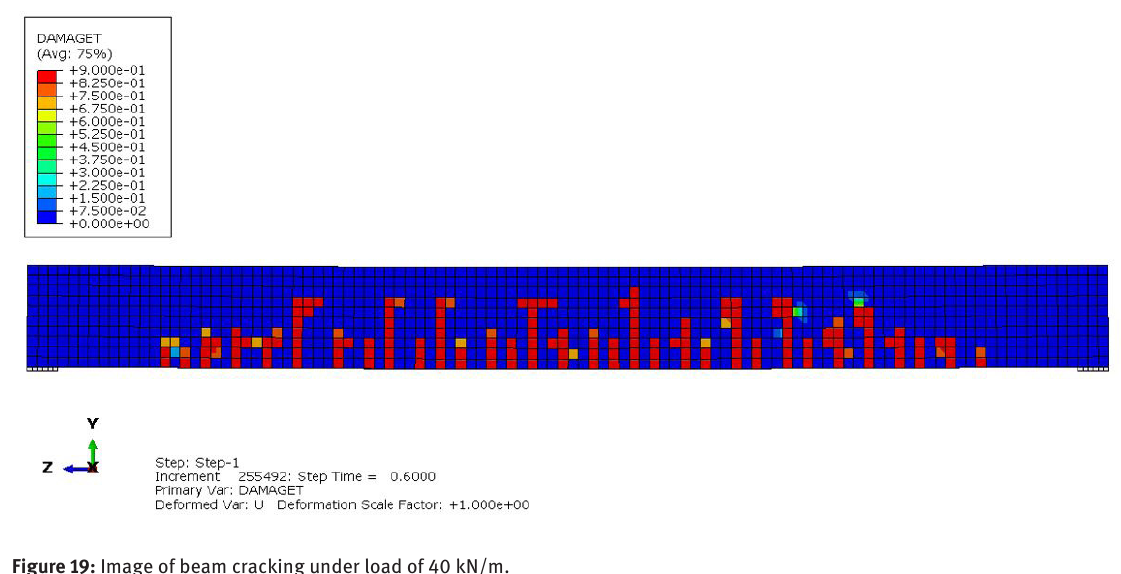
Figure 19: Image of beam cracking under load of 40 kN/m.